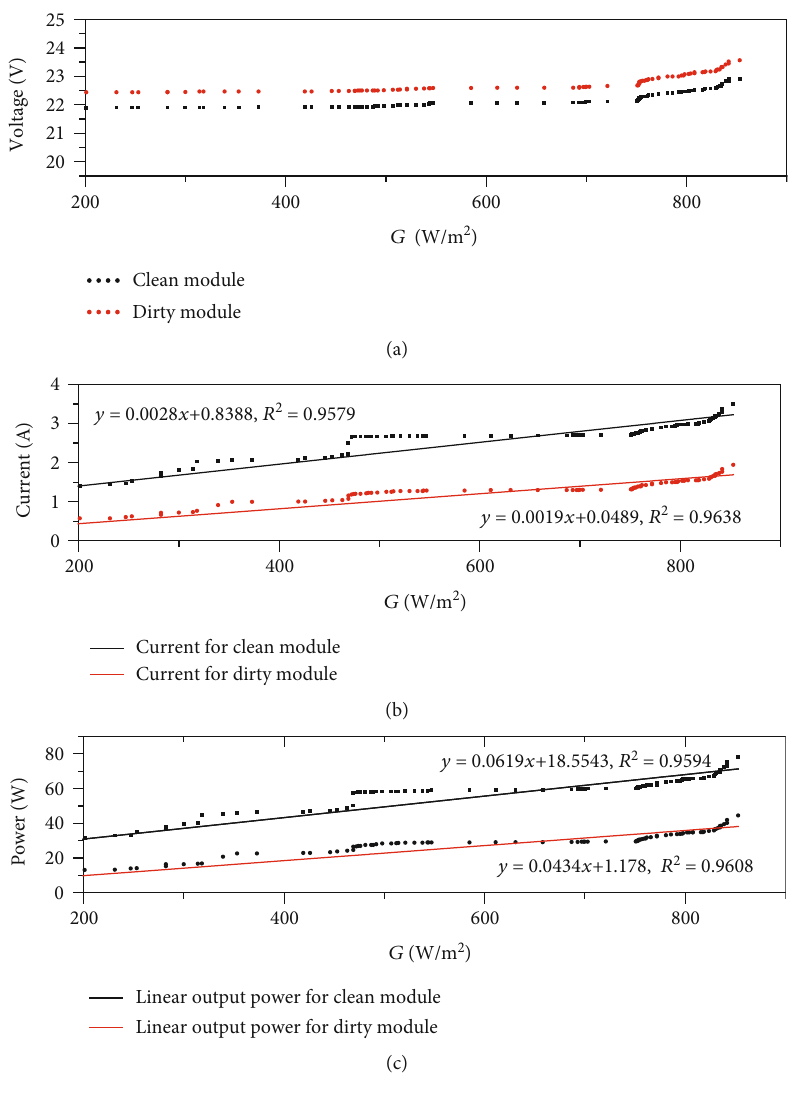
Figure 7: Impact of solar irradiance on operating voltage, current, and power output for clean and dirty modules (45-90 μ m aggregate